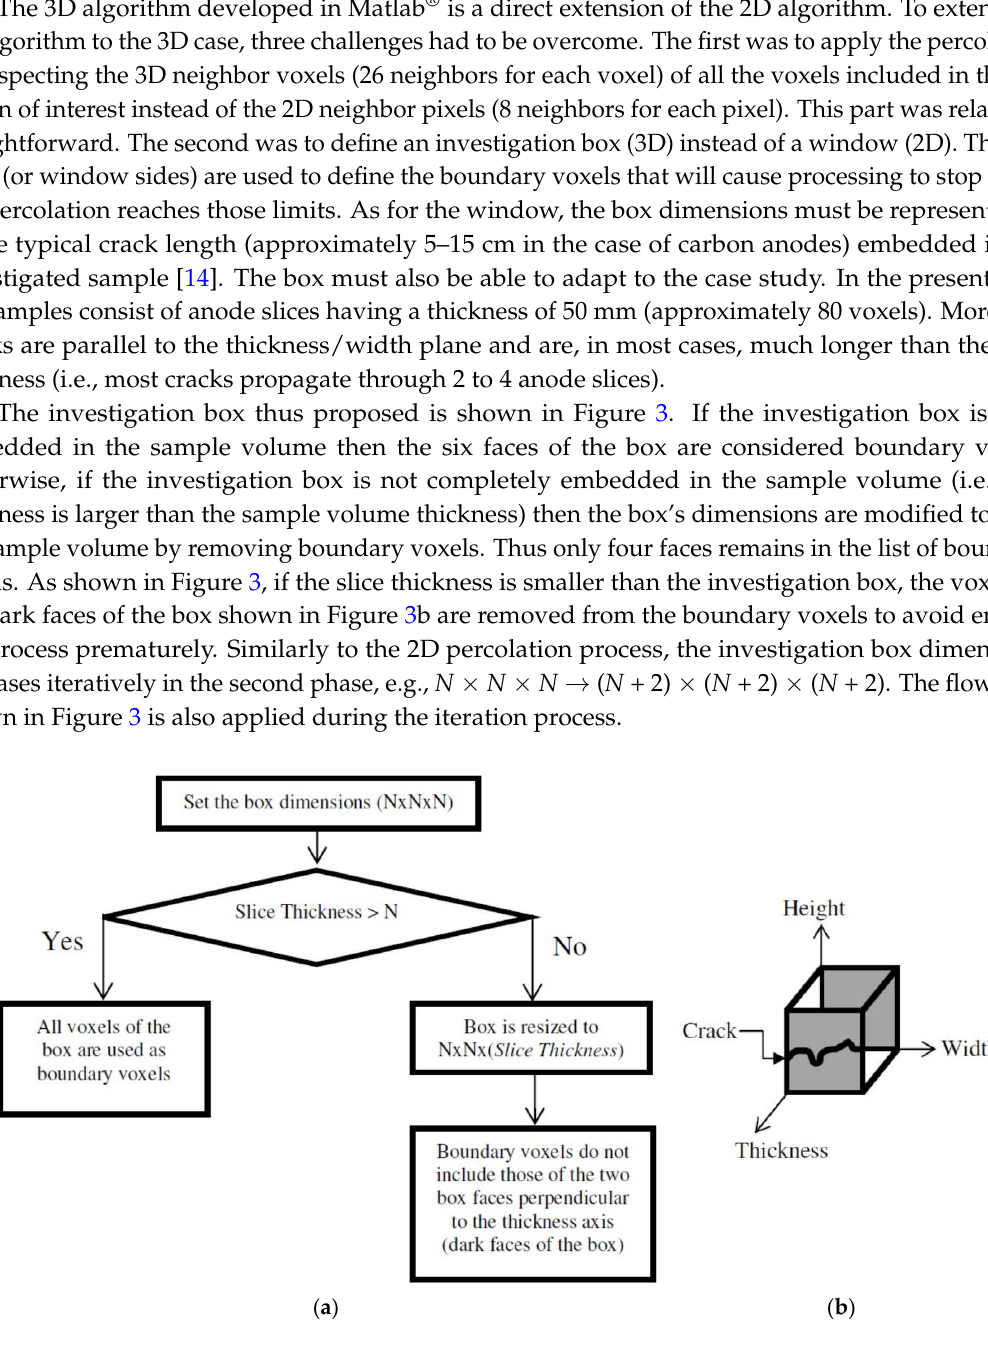
Figure 3. Flowchart for investigation box size determination: ( a ) flowchart; ( b ) investigation box.